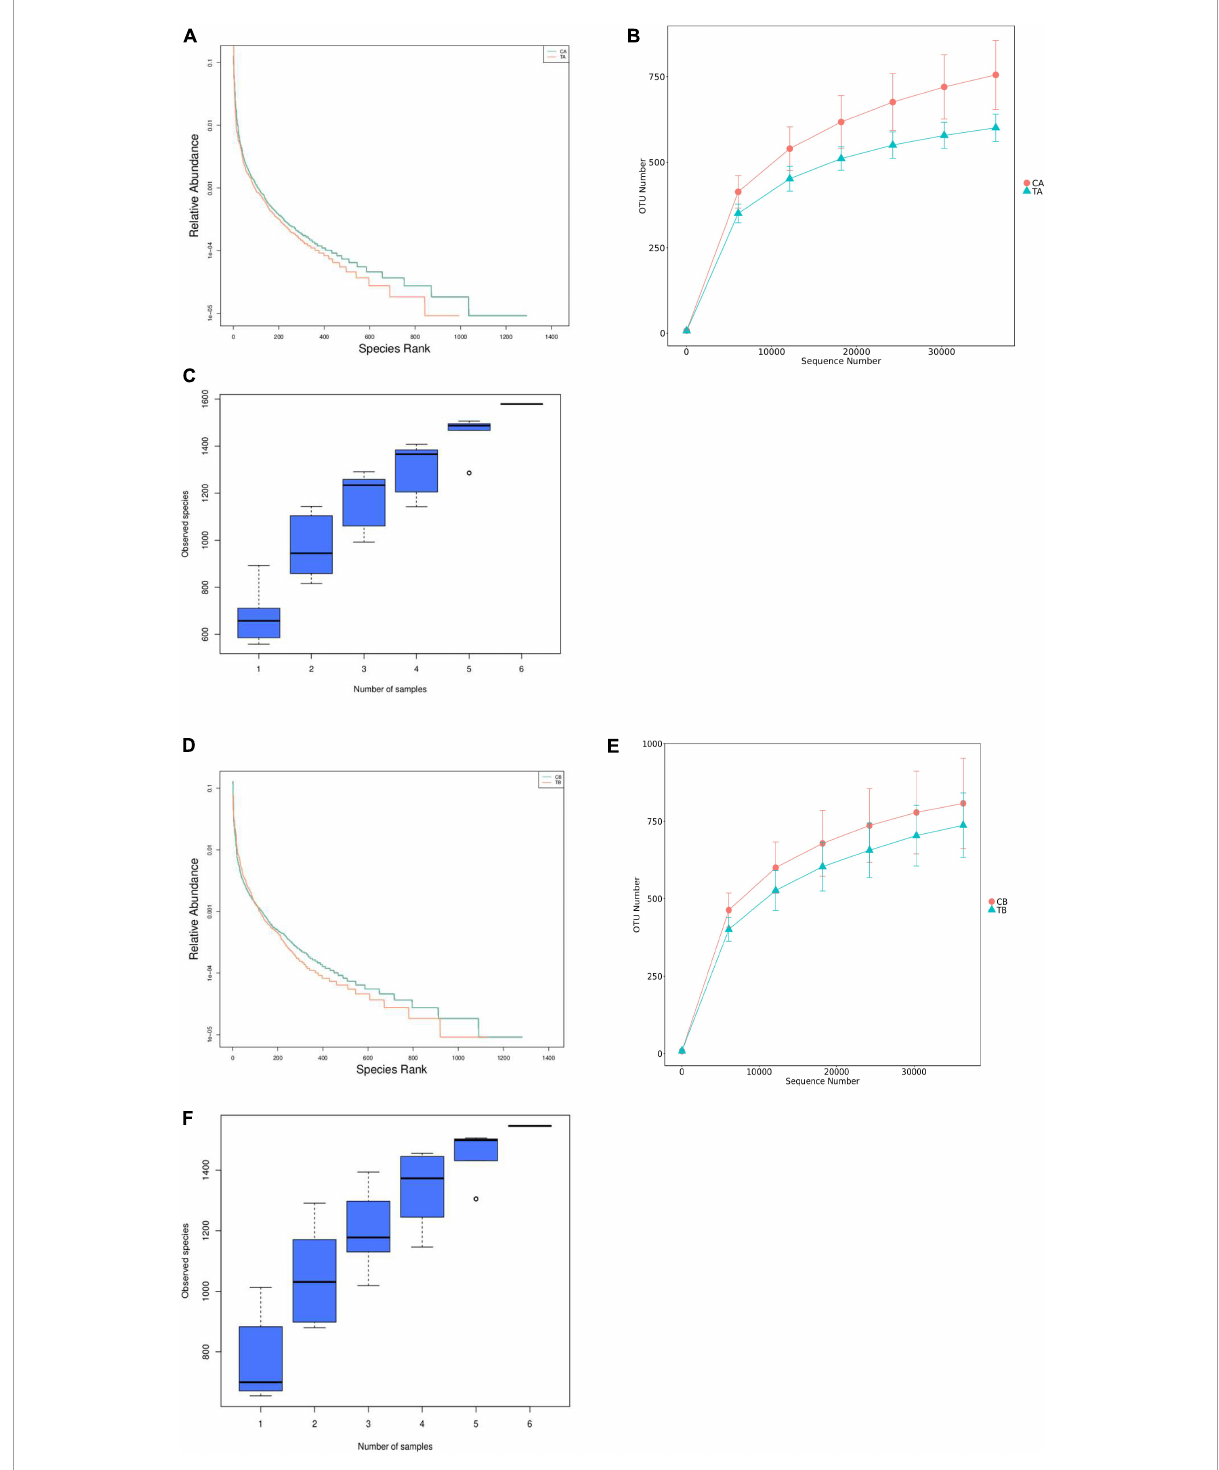
FIGURE2 Rank abundance, rarefaction curves, and species accumulation boxplot for intestinal microbiota of piglets weaned on day 14 of age (14W) and day 28 of age (28W) at different sampling timepoints [day 28 of age (A–C) ; day 70 of age (D–F) ]. CA group was defined as the sample from piglets in 28W group at the timepoint of day 28 of age. TA group was defined as the sample from piglets in 14W group at the timepoint of day 28 of age (A–C) . CB group was defined as the sample from piglets in 28W group at the timepoint of day 70 of age (D–F) . TB group was defined as the sample from piglets in 14W group at the timepoint of day 70 of